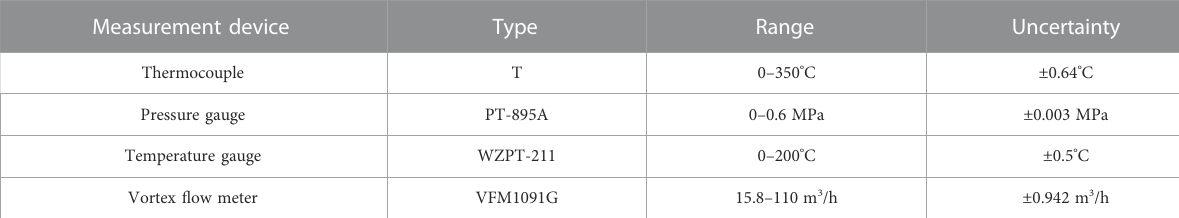
TABLE 1 Main parameters of the experimental measuring instrument.